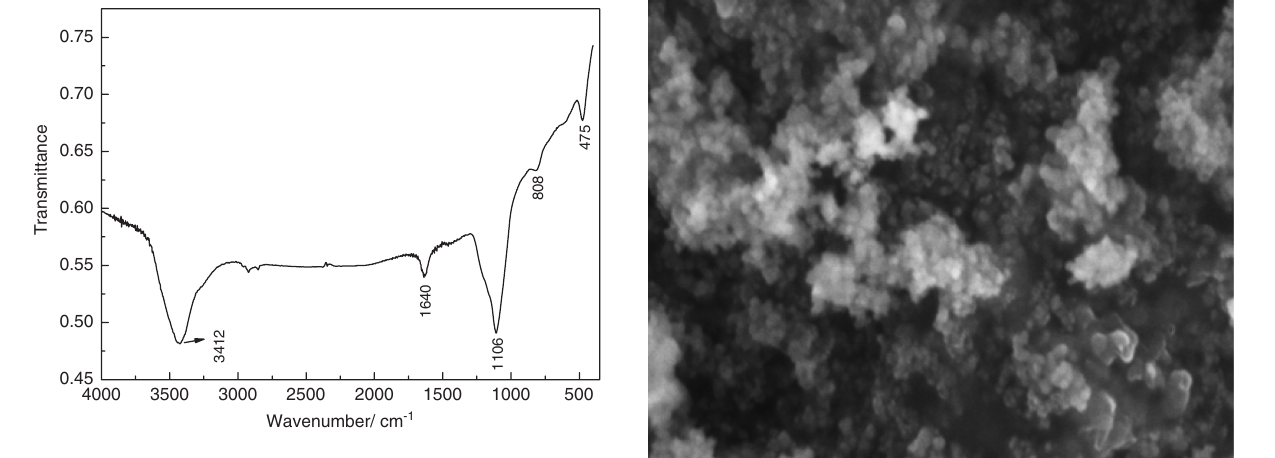
Figure 2 IR spectrum of unmodified nano-silica.